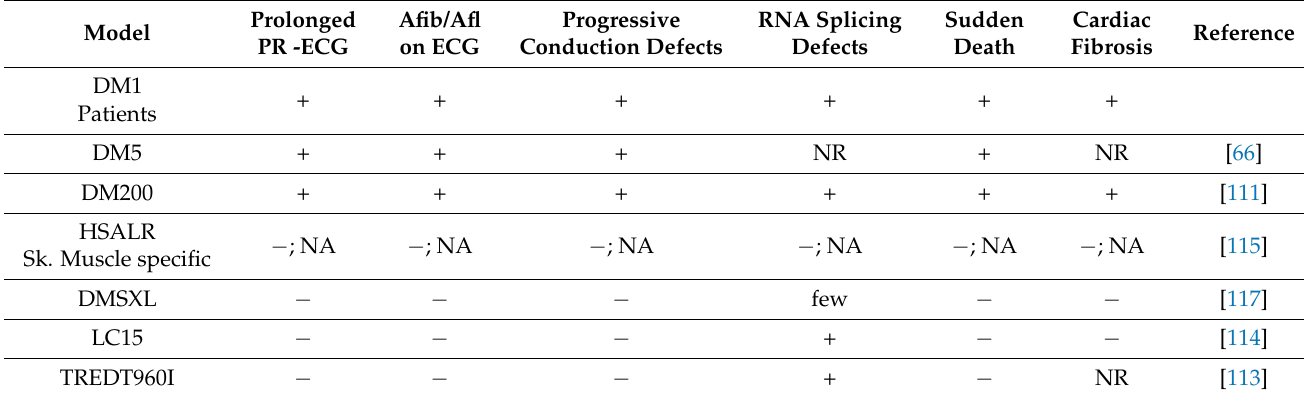
Table 1. Currently Existing Mouse models of RNA toxicity in DM1. Tabulation of relevant clinical and molecular phenotypes in various mouse models of RNA toxicity; + (present); − (absent). Abbreviations: NR, not reported; NA, not applicable.